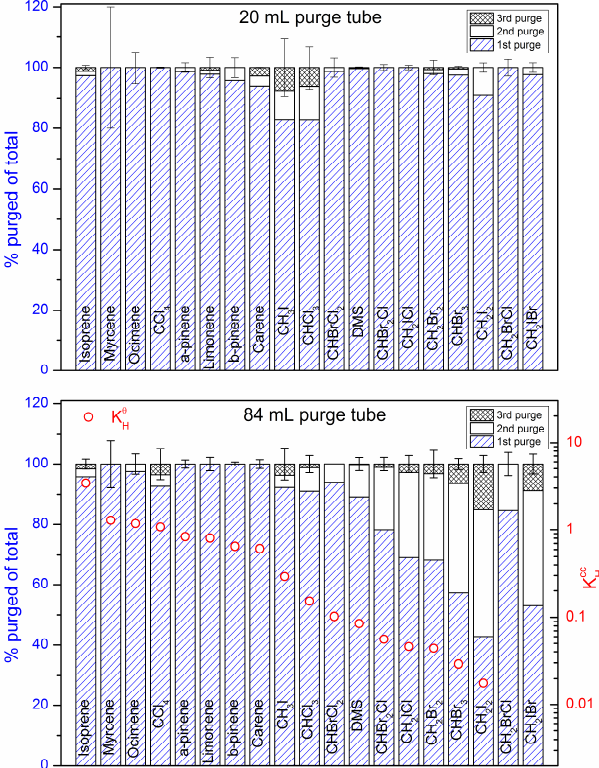
Figure 5. Purge efficiencies for 20mL (top) and 84mL (bottom) water samples. Blue bars represent the % purged from the sample in the first purge. Error bars show the run to run reproducibility of the system. For the 84mL samples K cc H is plotted as red circles and decreases with purge efficiency.